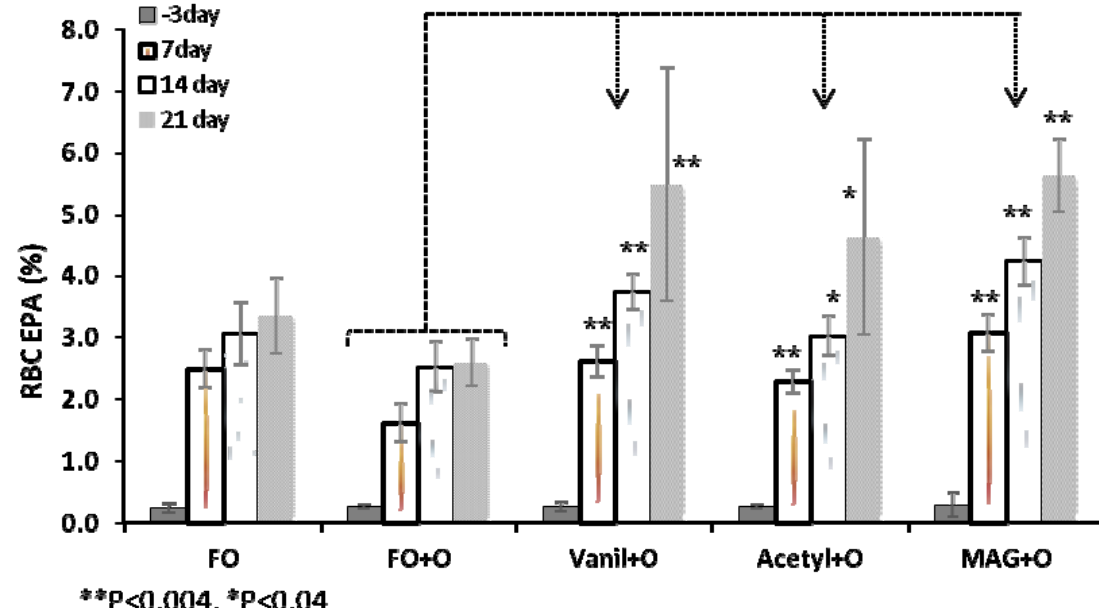
Figure 2. EPA in RBC at different time points, Median ±